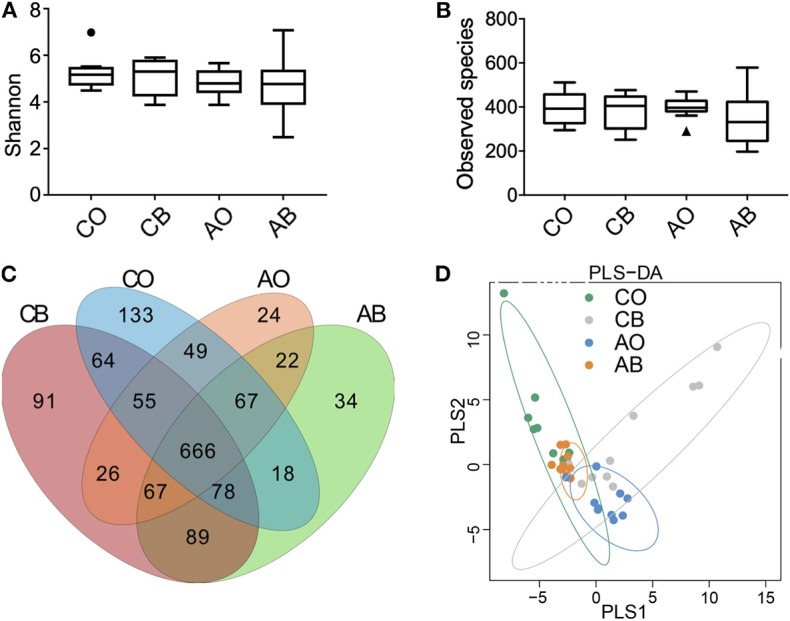
Indices of oral bacterial diversity. (A) Calculations of Shannon indices among groups CO, CB, AO, and AB; (B) calculations of species observed among groups CO, CB, AO, and AB; (C) scalar Venn diagrams among groups CO, CB, AO, and AB; (D) PLS-DA analysis of groups CO, CB, AO, and AB. CO, oral microbiota of people using traditional Chinese medicinal toothpaste (n = 10); CB, microbiota of toothbrushes corresponding to group CO (n = 10); AO, oral microbiota of people using antimicrobial toothpaste (n = 10); AB, microbiota of toothbrushes corresponding to group AO (n = 10).